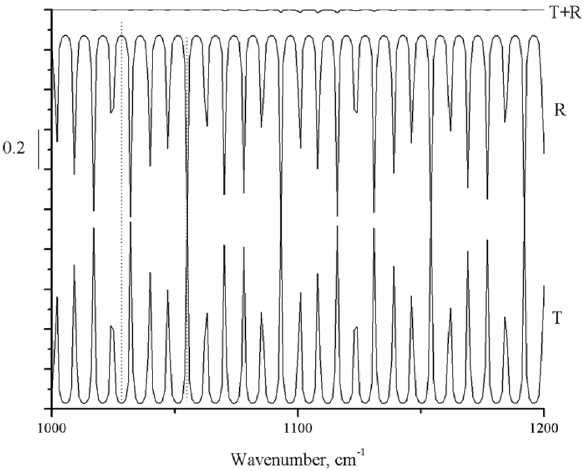
Figure 3. Simulation of reflectance R, transmittance T and addition of R + T of s-polarized light vs. wavenumber. MTR parameters for calculation: incidence angle = 74°, n 1 = 1.0, and b = 0.02 cm. The image was created using Origin 2017 (simplified Chinese), http://www.32r.com/soft/16769